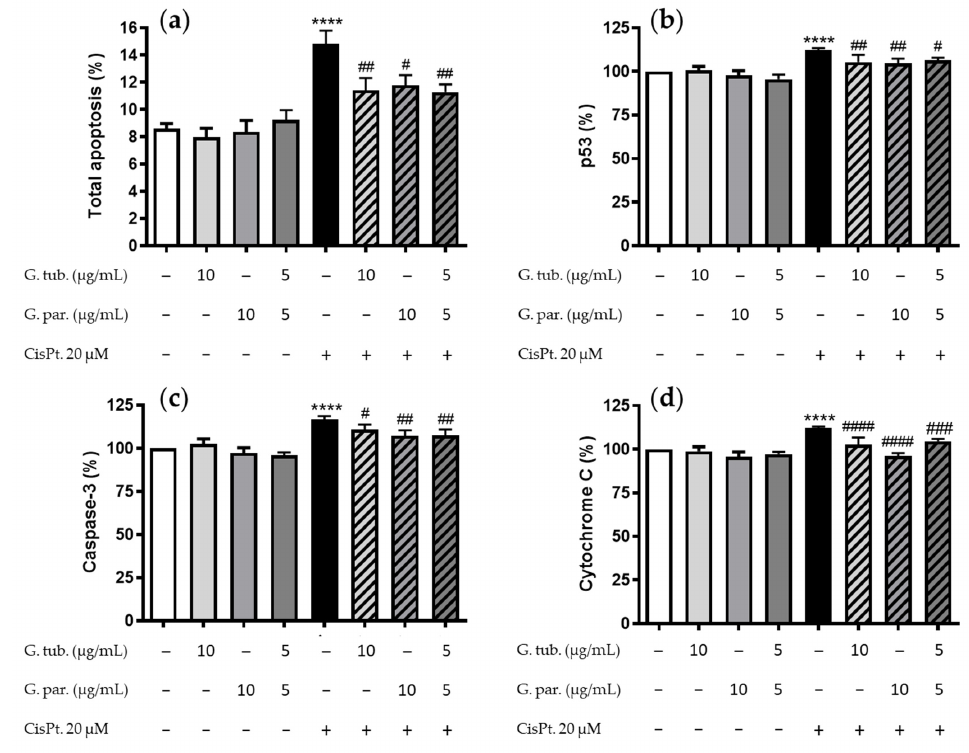
Figure 2. Apoptosis determinations assessed using flow cytometry of cells exposed during 24 h to CisPt 20 µM and/or the G. tub. extract (10 µg/mL), the G. par. extract (10 µg/mL), or the G. tub. and G. par. association extract (each at 5 µg/mL). ( a ) The total apoptosis process was determined follow- ing Annexin V/PI staining, and results are shown as mean ± SD of three independent experiments (**** p < 0.0001 compared to controls; ## p < 0.01 and # p < 0.05 compared to CisPt. 20 µM). Three markers were analyzed, and their respective normalized fluorescence compared to the controls is shown as follows: ( b ) intracytoplasmic p53 proportion, ( c ) membranous caspase-3 proportion, and ( d ) intracytoplasmic cytochrome C proportion. Results are shown as mean ± SD of three independ- ent experiments (**** p < 0.0001 compared to controls; #### p < 0.0001, ### p < 0.001 ## p < 0.01, and # p < 0.05 compared to CisPt. 20 µM). The signs + and − indicate the presence or the absence of the corresponding treatment, respectively. Among the three markers studied, namely p53, caspase-3, and cytochrome C, the mushroom extracts did not affect their intracytoplasmic proportions compared to the con- trols. The p53 proportion increased up to 112 ± 5% by CisPt (Figure 2b). This increase was prevented by G. tub. (105 ± 3%), G. par. (105 ± 6%), and their association (107 ± 4%). The caspase-3 proportion increased up to 117 ± 7% by CisPt (Figure 2c). This increase was prevented by G. tub. (110 ± 7%), G. par. (107 ± 8%), and their association (107 ± 8%). The cytochrome C proportion increased up to 112 ± 4 % by CisPt (Figure 2d). This increase was prevented by G. tub. (103 ± 9%), G. par. (96 ± 4%), and their association (104 ± 3%).